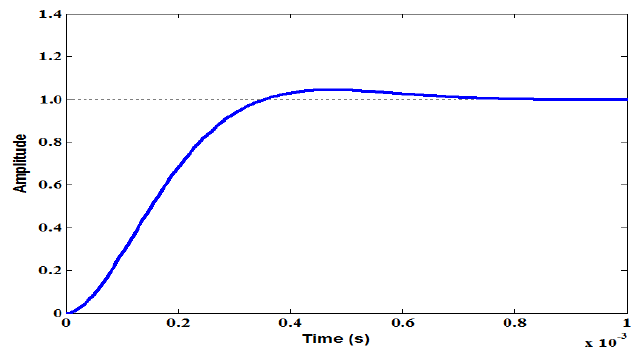
Fig. 7. Step response of the inner current control